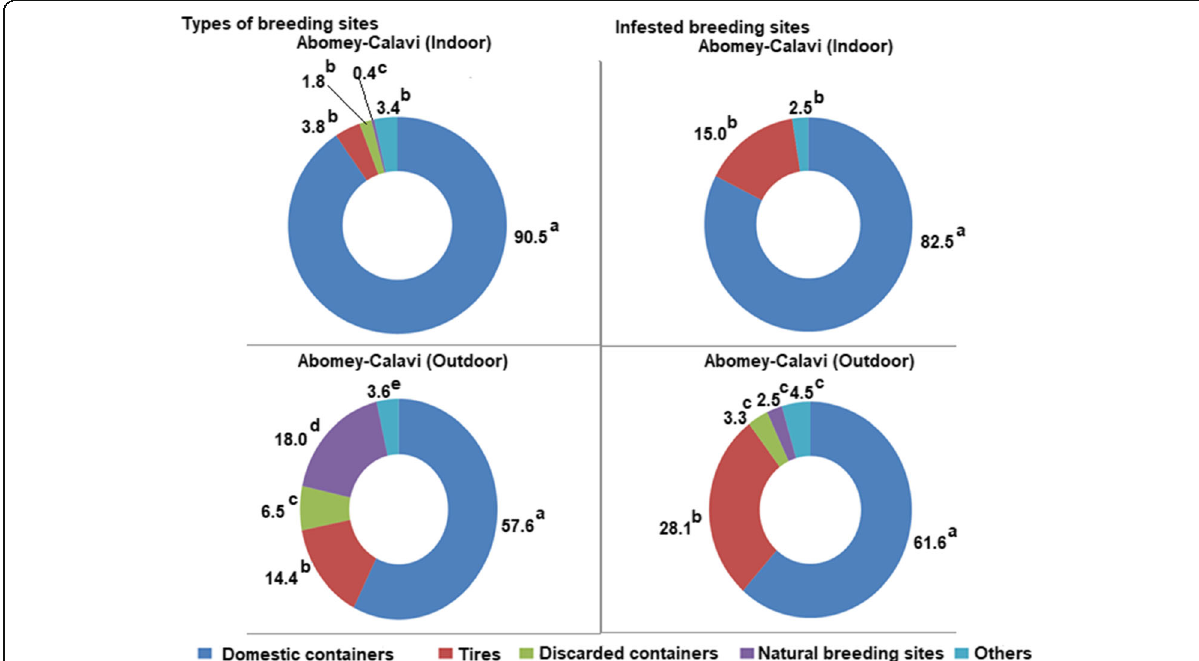
Fig. 2 Proportion of potential and positive of breeding site types located indoors and outdoors in Abomey-CalaviFor a same parameter, parts of a same circle diagram with values holding different superscripts are significantly different ( p <